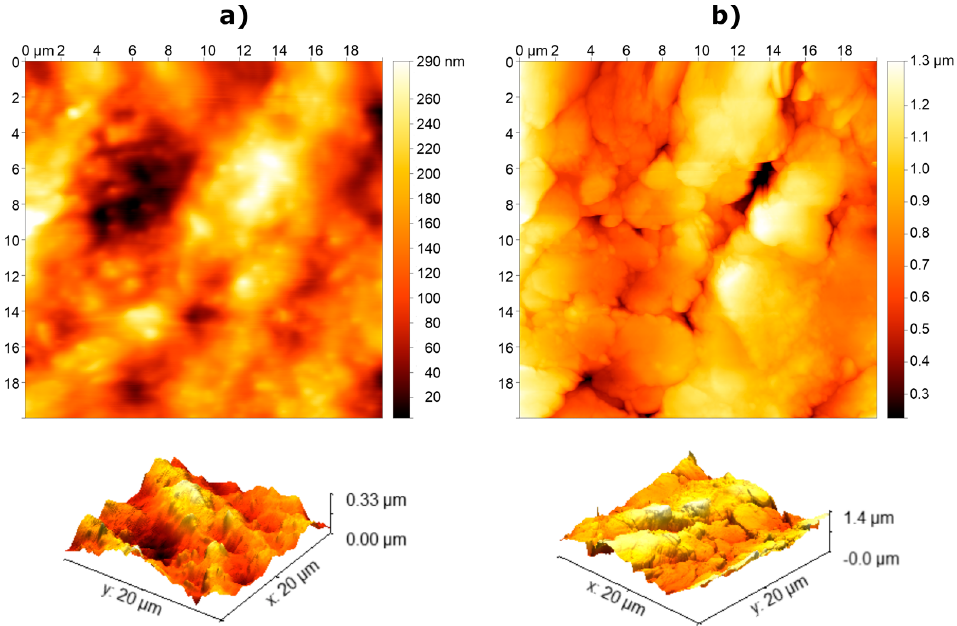
Figure 6. AFM surface measurements (2D and 3D topography) of the printed electrode surface. ( a ) White dielectric layer. ( b ) Silver electrode pad.